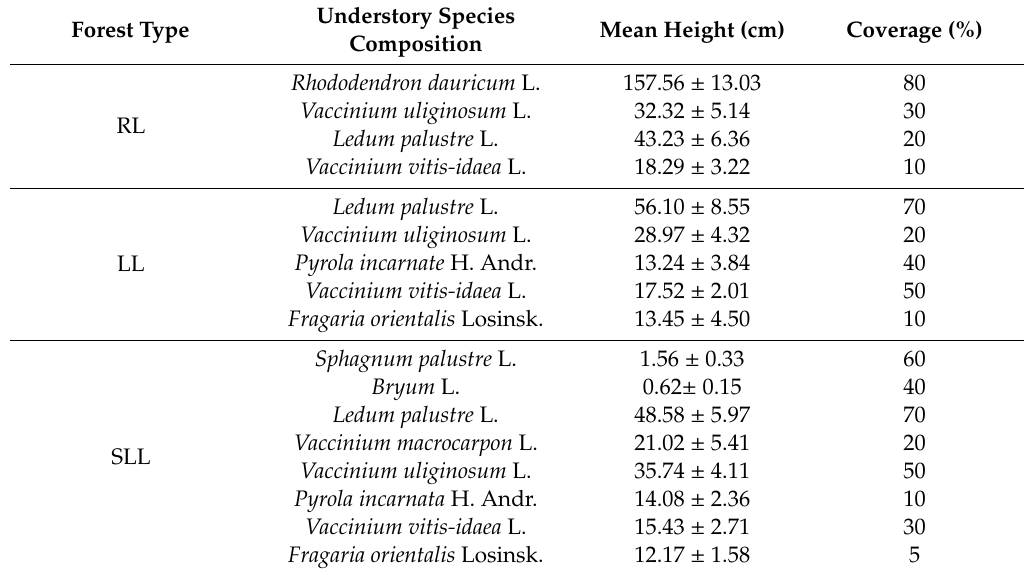
Table 2. The characteristics of the main understory in the three types of larch forest ecosystems. Forest Type